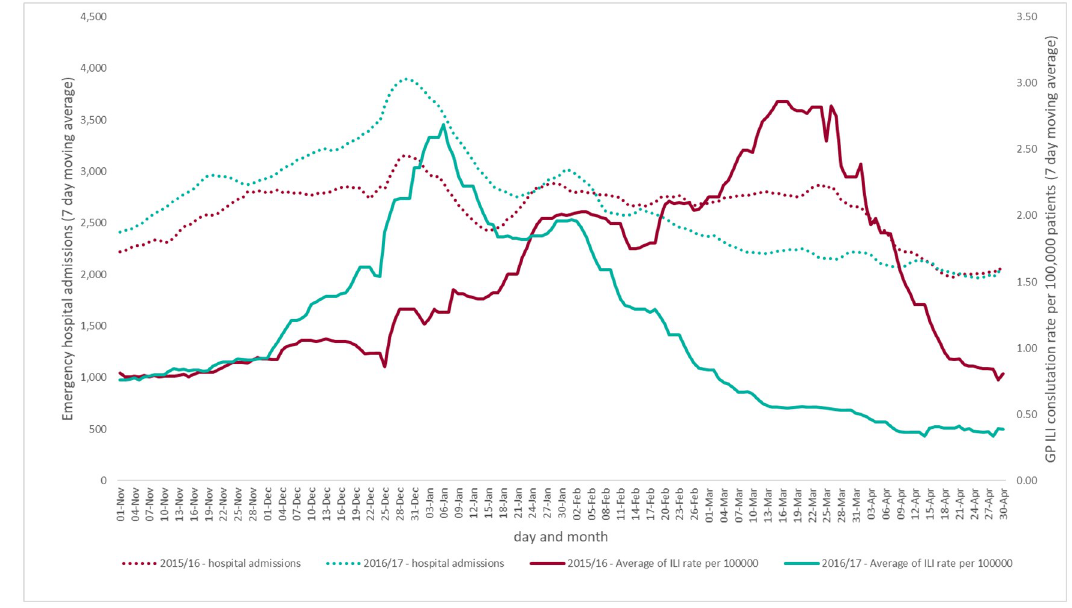
Fig 1. Comparison of GP influenza-like illness consultations and emergency hospital admissions across two seasons.